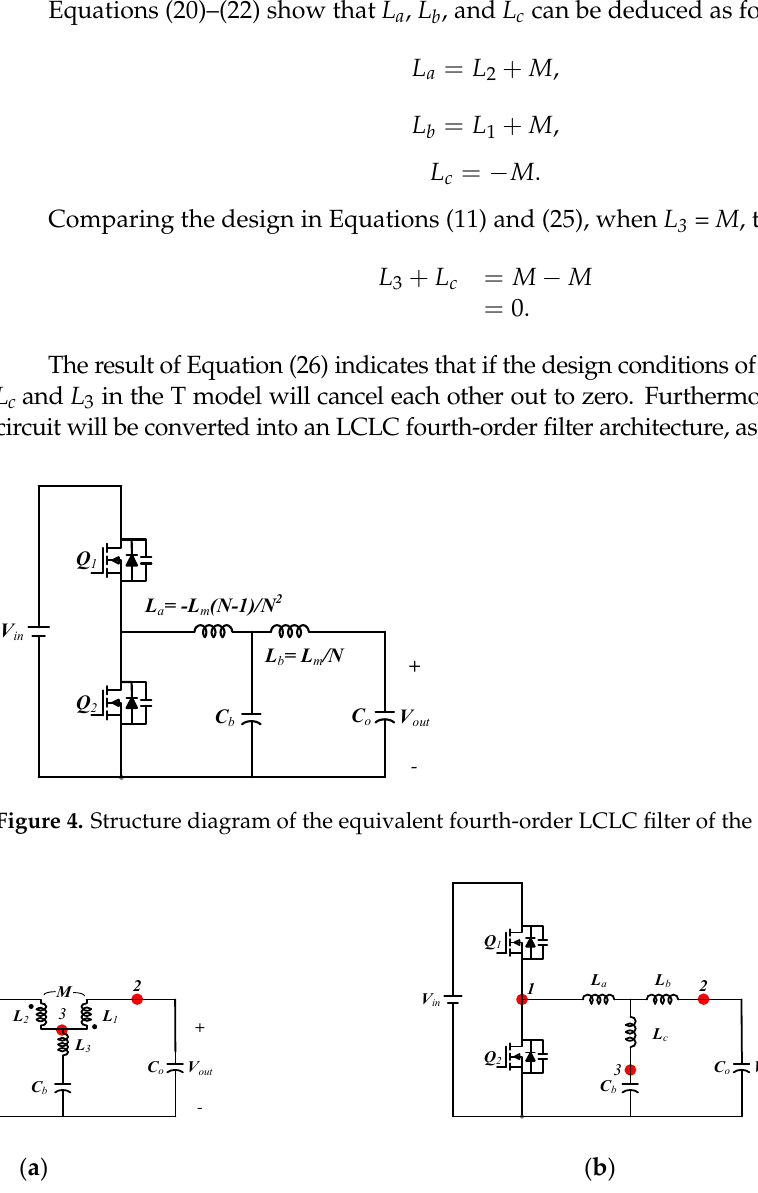
Figure 5. LL-LC circuit: ( a ) transformer type; ( b ) T-type equivalent form.